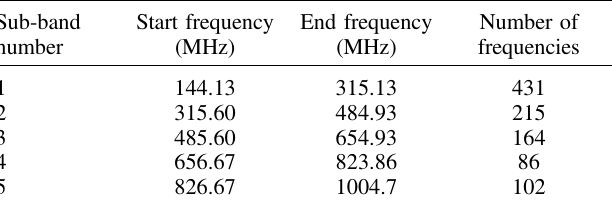
Table 3. ORFEES sub-bands with the frequency range and the number of frequencies for each